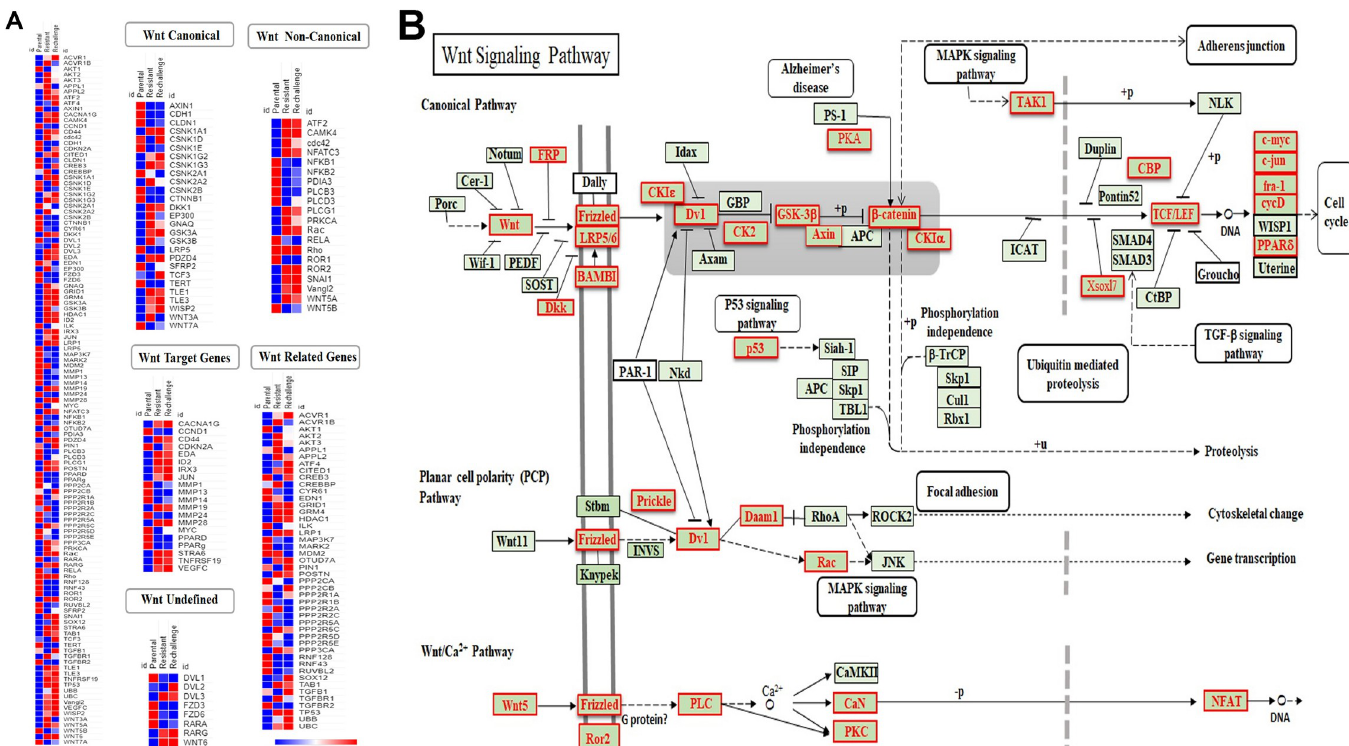
Fig 5. Major representation of Wnt non-canonical genes in CabR cells. (A) Heat map (GENE-E software) showing the expression profiles of specific effectors of the Wnt pathways in age-matched (parental), and CabR (resistant) and re-challenged Du145 cells. (B) Wnt pathways generated using KEGG (Kyoto Encyclopedia of Genes and Genomes) software. Genes found differentially expressed in our RNA-Seq data set are highlighted in red.